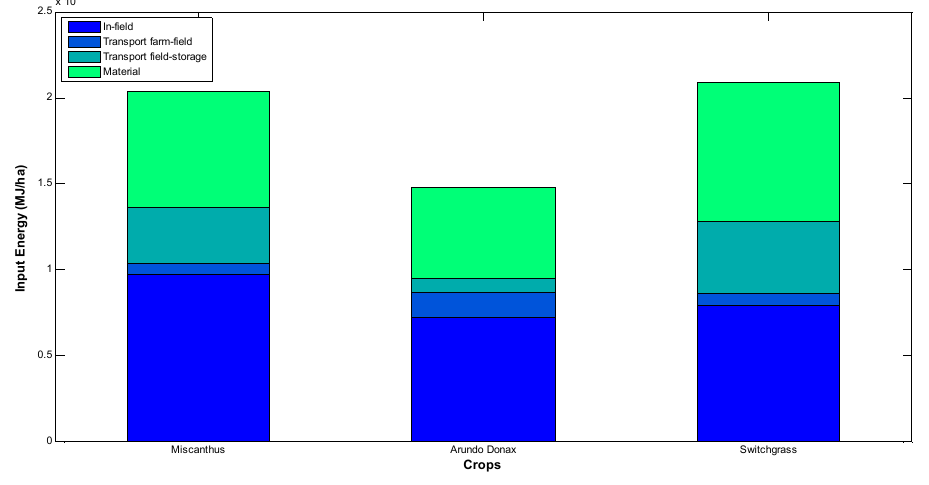
Figure 6. Input energy distribution in MJ · ha − 1 for the three crops per 10 years cycle.